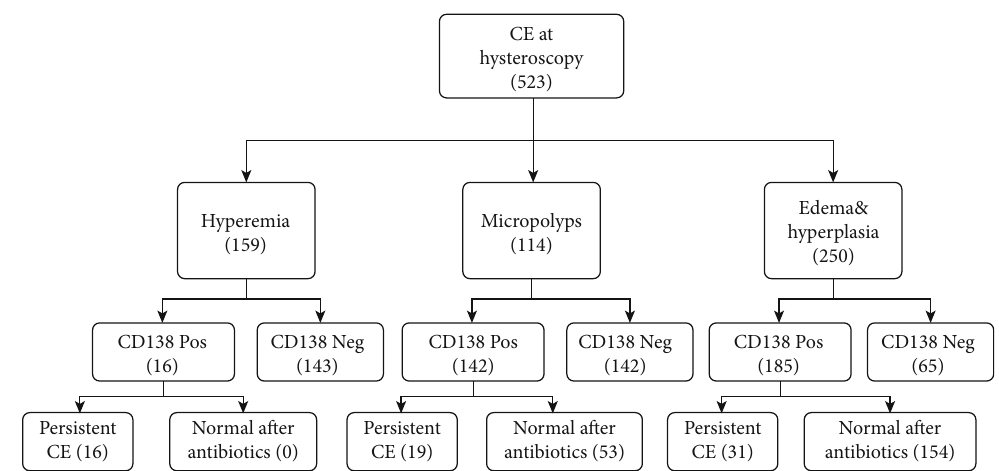
Figure 2: Flowchart diagram of patient population distribution into various cohorts. CE: chronic endometritis; CD138Pos: ≥ 5 CD138+ Table 1: Clinical characteristics of patients with